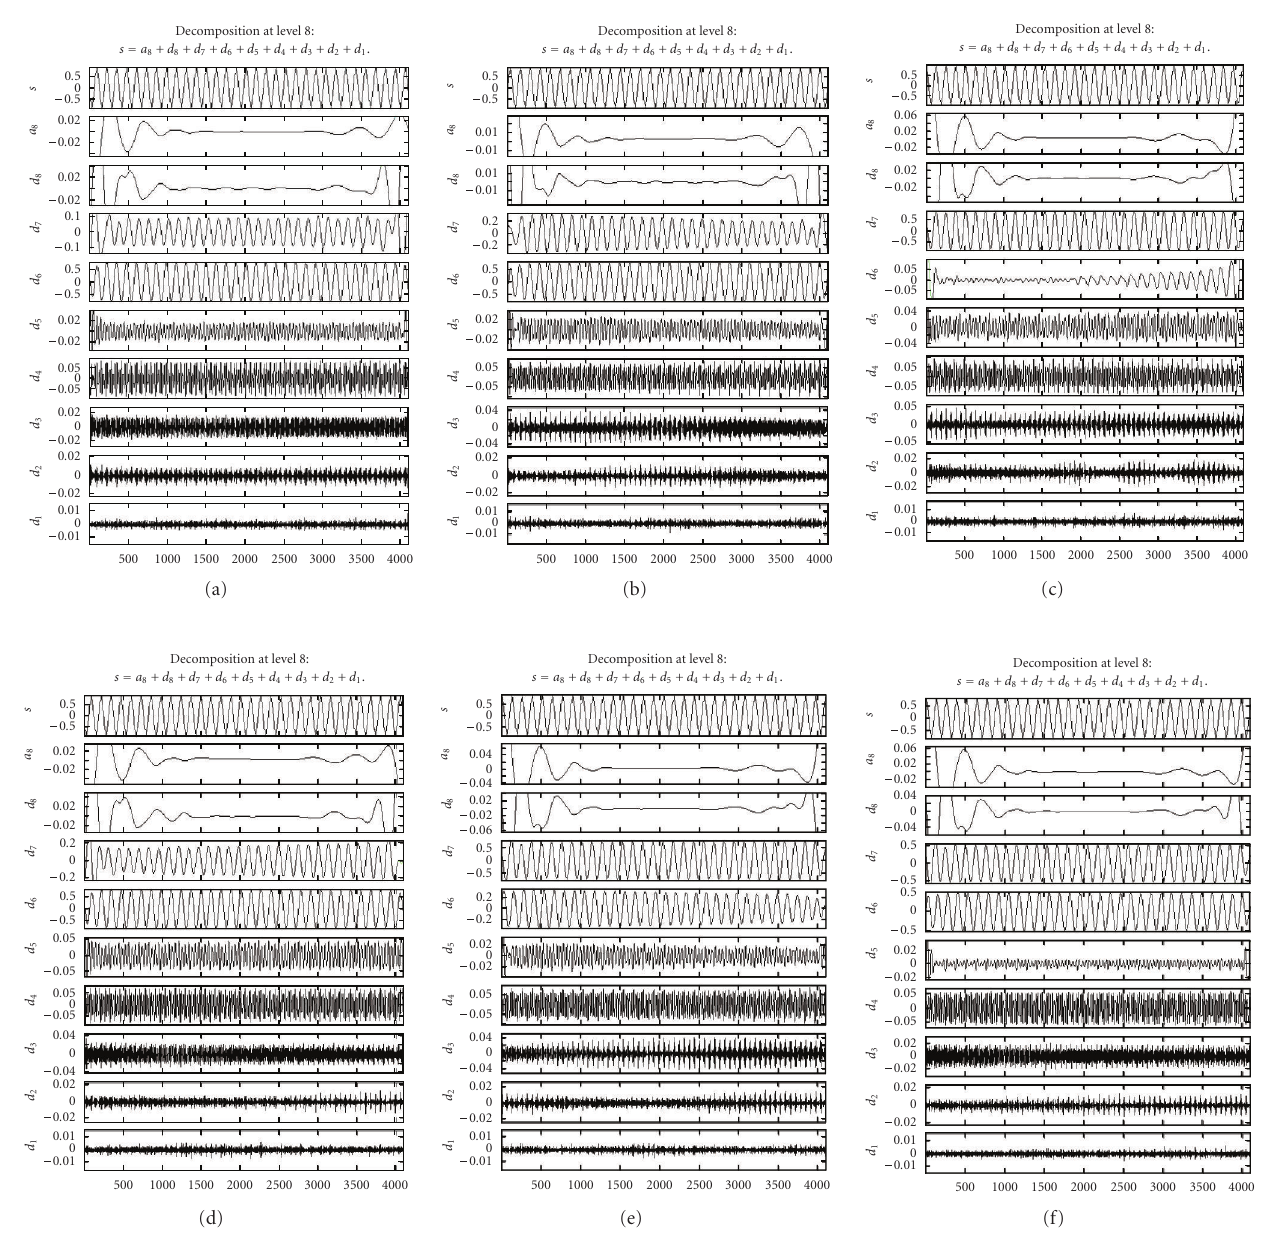
Figure 7: Details of motor stator current signals under no-load condition. (a) Normal condition, (b) bowed rotor, (c) broken rotor bar, (d) faulty bearing (outer race), (e) rotor unbalance, (f)